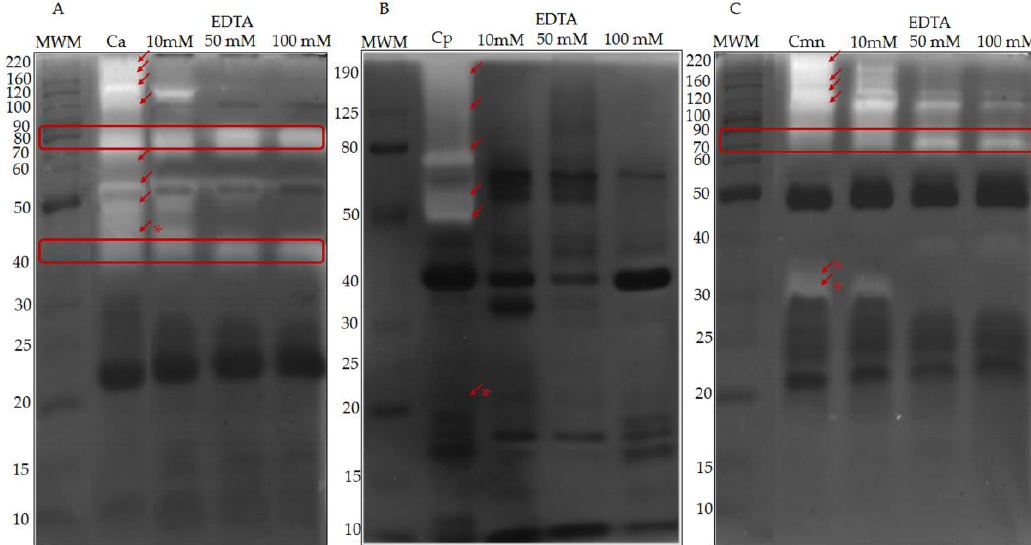
Figure 5. Zymography in 10% polyacrylamide gels co-polymerized with gelatin. Ten microgram of venom protein from ( A ) C. aquilus (Ca), ( B ) C. polystictus (Cp), and ( C ) C. molossus nigrescens (Cmn). In addition, 10 μg of the same samples were tested with 10, 50 and 100 mM EDTA in gels that were incubated after electrophoresis for 2.5 h at 37 °C. Red arrows indicate inhibition of snake venom metalloproteases (SVMP) by EDTA, red asterisk (*) show bands not shared between the venoms, red boxes show proteases bands with gelatinolytic activity unaffected by EDTA. Molecular weight markers (MWM) in kDa.